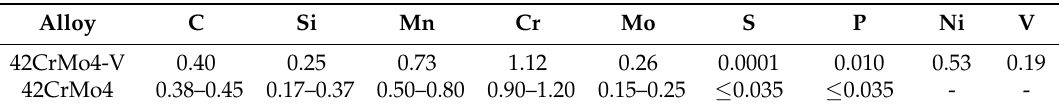
Table 1. Chemical compositions of 42CrMo4-V steel and traditional 42CrMo4 steel (wt. %). Alloy C Si Mn Cr